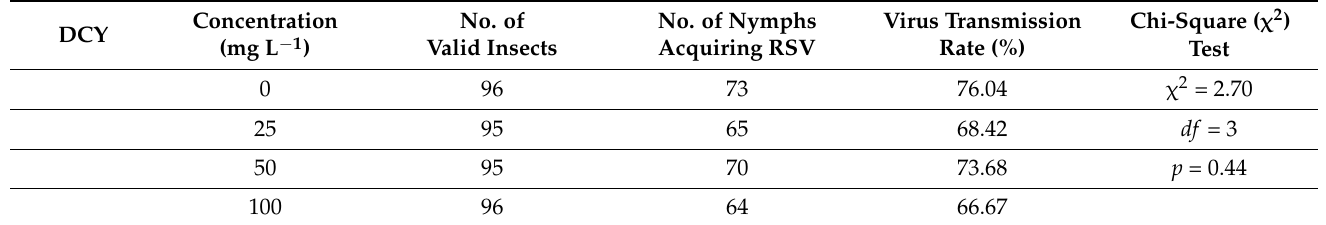
Table 3. RSV vertical transmission rate of SBPH fed on DCY-treated